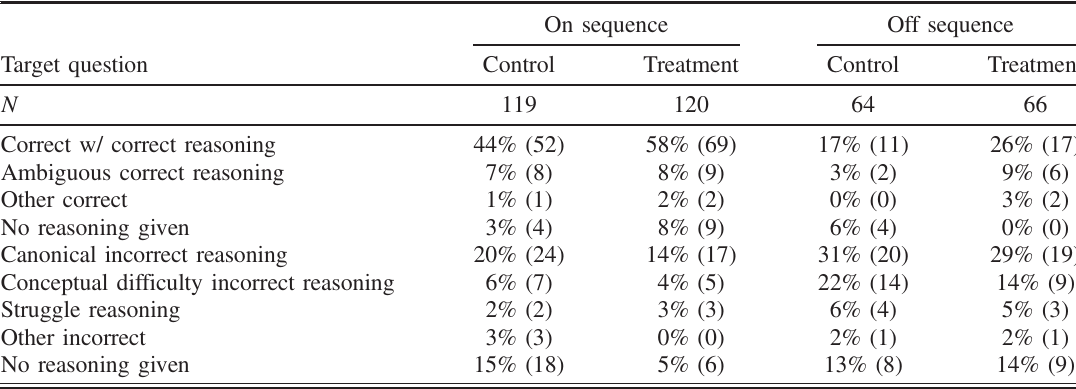
TABLE VIII. Comparison of reasoning chain categories in experiment 2A for on-sequence and off-sequence courses. Percentages shown represent percentage of students in the respective column. (In the text, percentages of correct or incorrect responses were reported for ease of